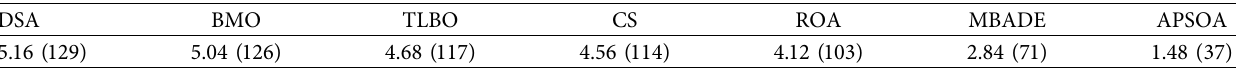
Table 6: Summary of the results presented in Table 5 (average rank of each method on all functions of the CEC 2005 benchmark). DSA